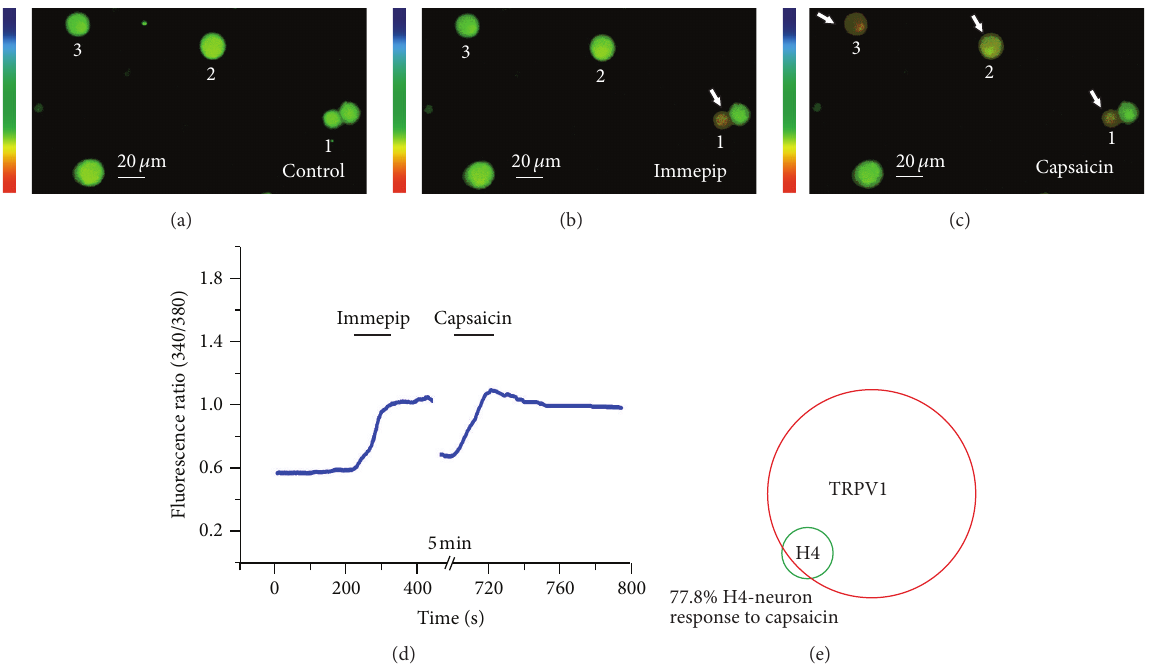
Figure 3: Immepip-sensitive DRG neuron responds to capsaicin. (a) Control, (b) immepip-induced increase in [ Ca 2+ ] i of DRG neuron 1. (c) Capsaicin-induced increase in [ Ca 2+ ] i of DRG neurons 1, 2, and 3. (d) Representative traces of another DRG response to immepip (50 𝜇 M) and capsaicin (1 𝜇 M). (e) Venn diagram showing relative proportion of immepip-sensitive DRG neuron responsive to